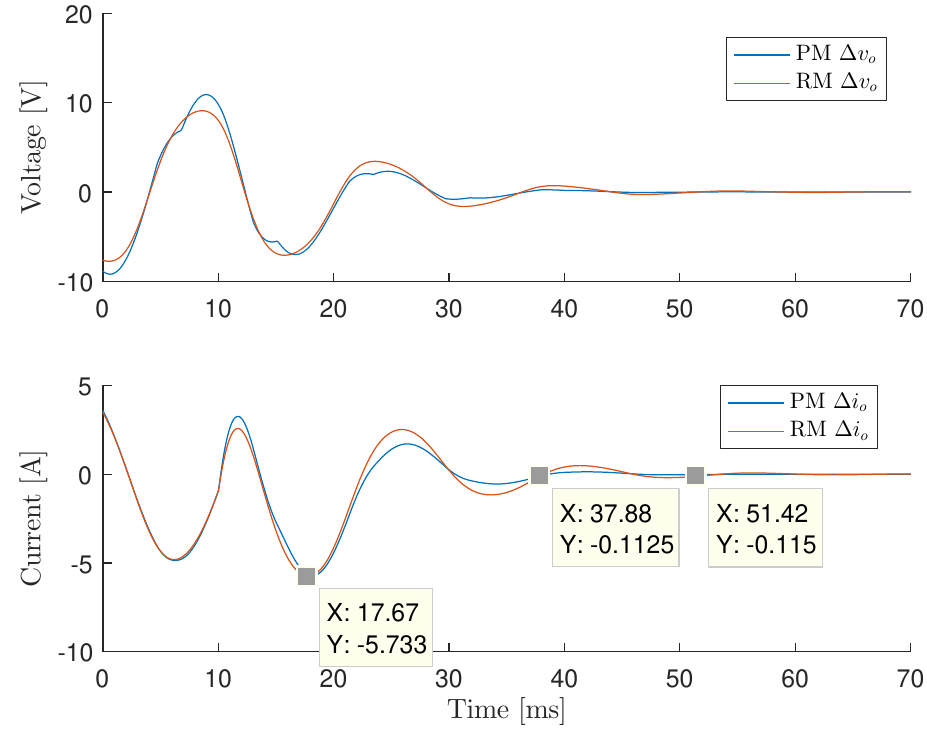
Figure 8. Difference between output voltage and output current of each oscillator without pre-